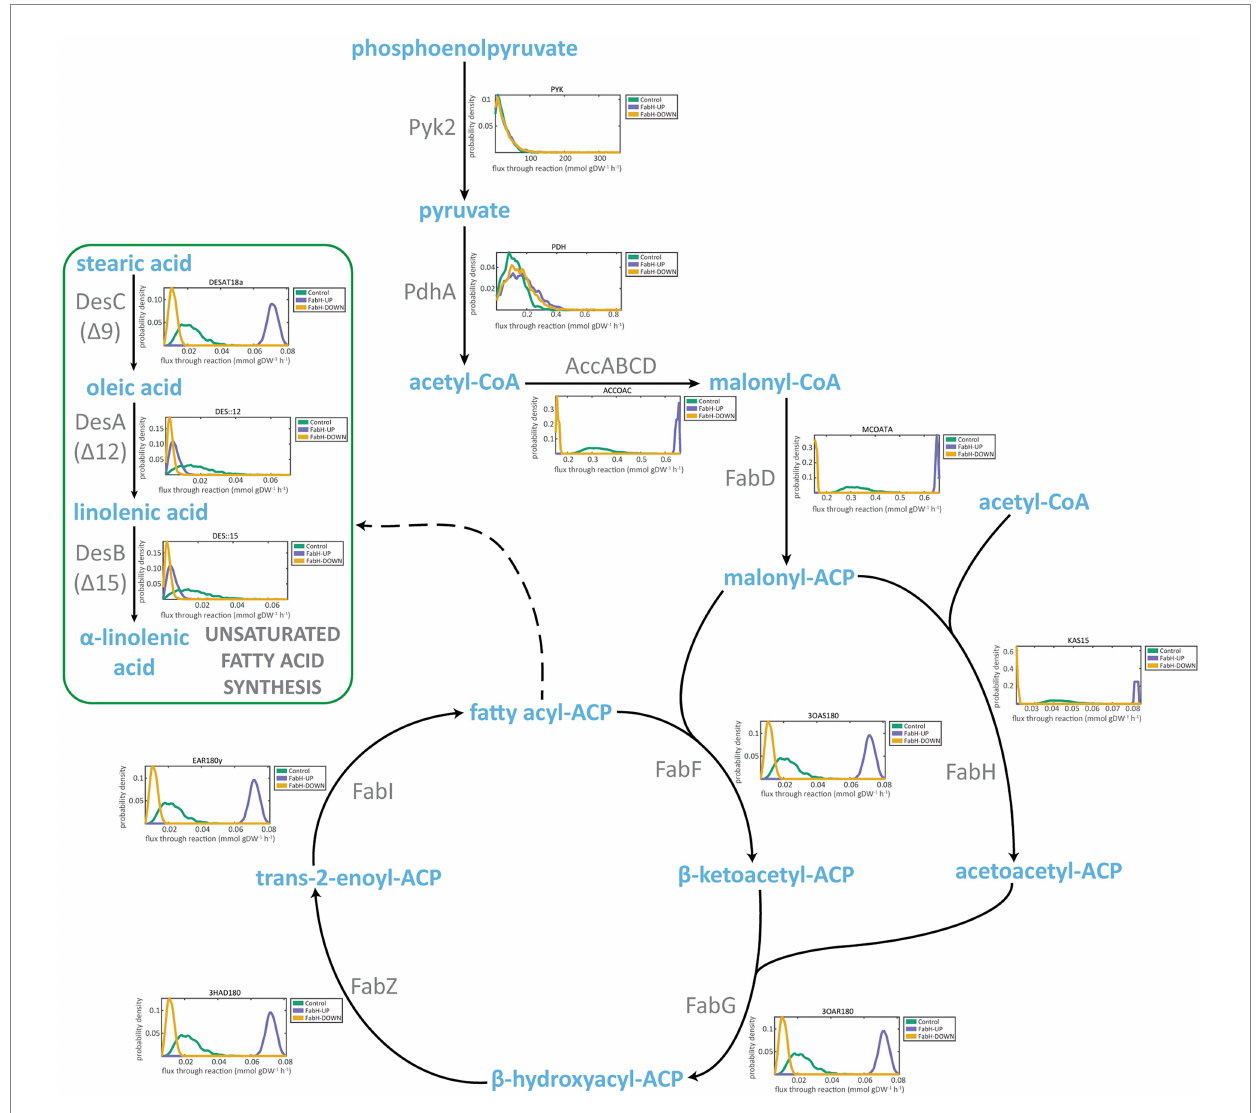
FIGURE 4 Flux sampling distributions of main reactions of ALA synthesis for in silico FabH overexpression and downregulation mutants and predicted using i MS837. For each reaction, a plot of the probability density versus the predicted flux of the specific reaction is represented. In green, the results obtained for i MS837_ALA are represented (Control); in purple, an in silico designed strain that has double flux for FabH reaction (KAS15) than i MS837_ ALA (FabH-UP); and in yellow, an in silico designed strain that has half flux for FabH reaction (KAS15) than i MS837_ALA